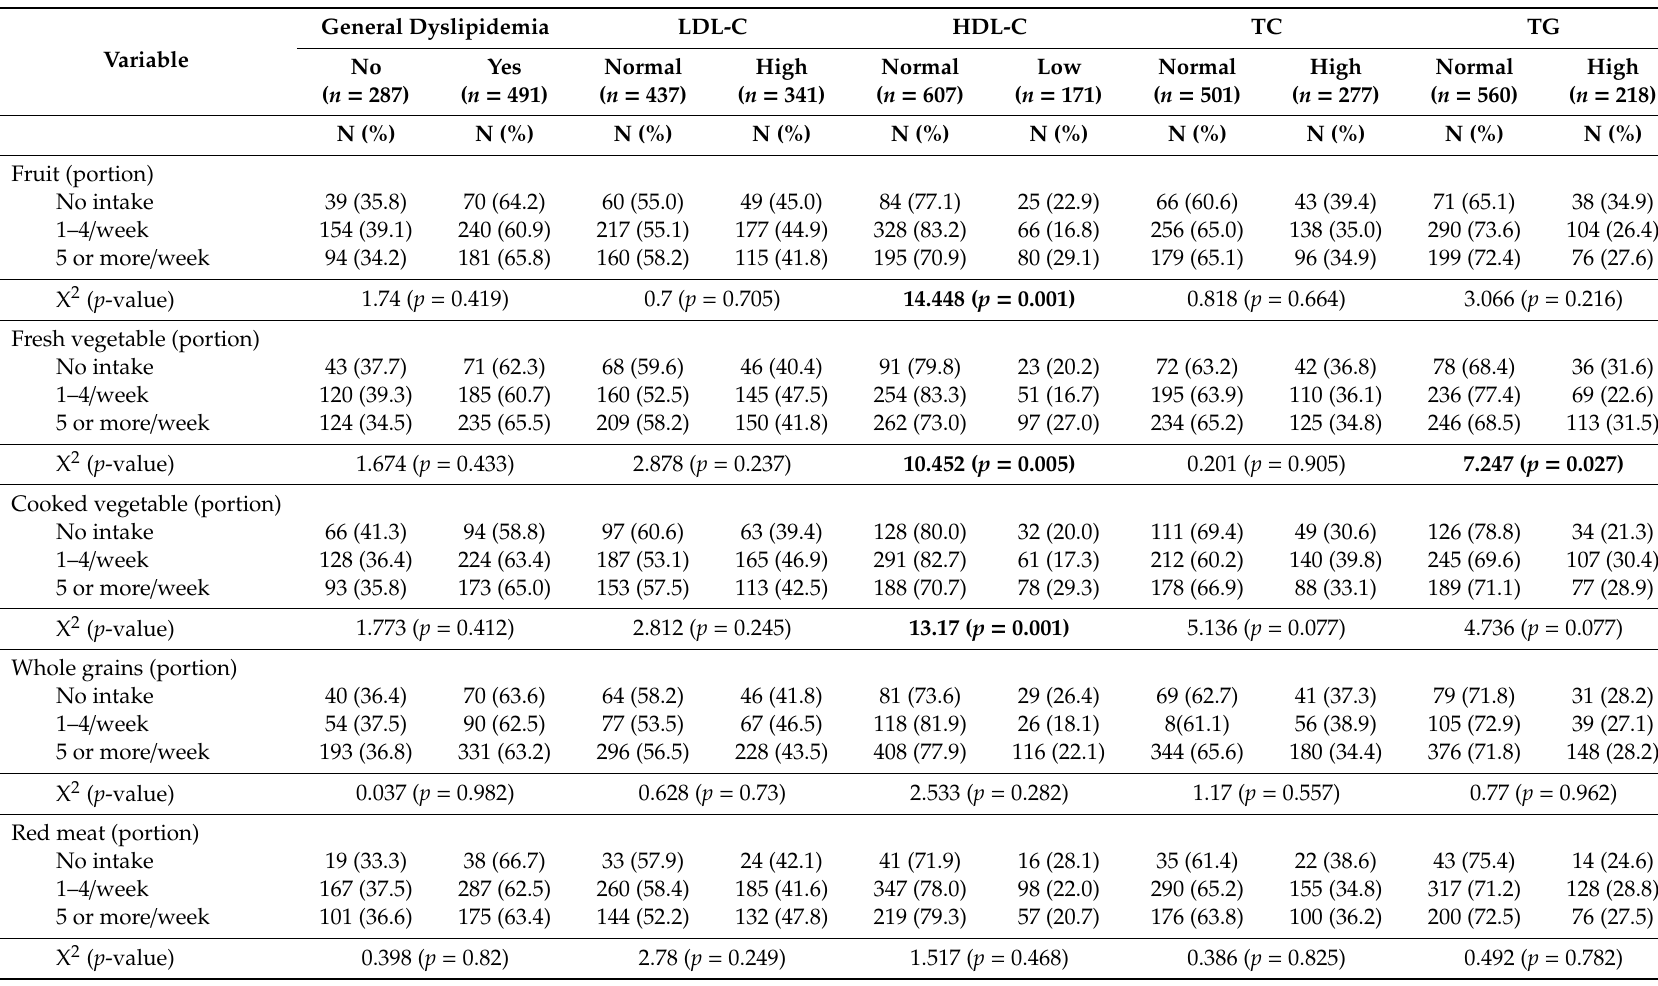
Table 2. Comparison of dietary habits between normolipidemic and dyslipidemic men groups presented as number of men (%) for overall dyslipidemia, and abnormalities in di ff erent lipid